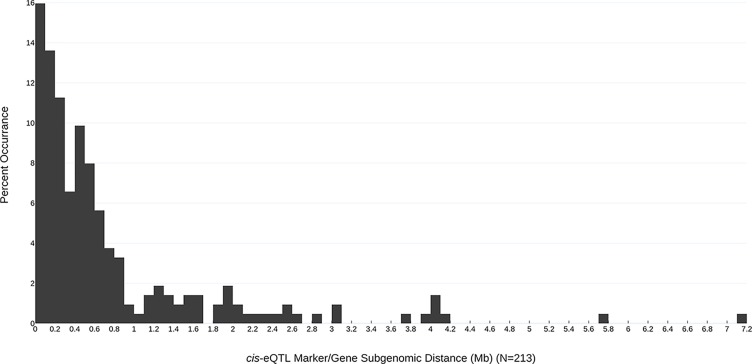
Subgenomic distances (Mb) between the most-correlated cis-eQTL marker and the originating gene locus. The frequency of each marker/gene distance observation is indicated (bin size = 0.1 Mb).